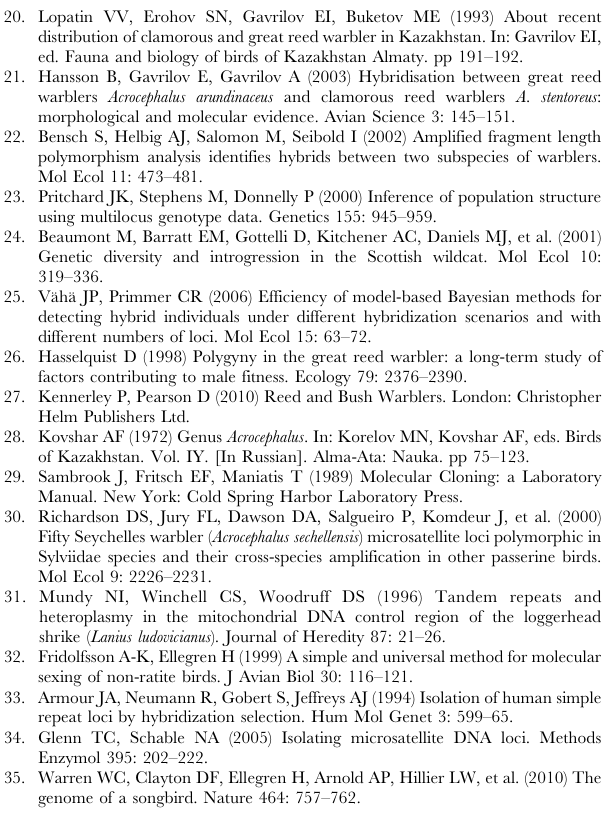
Figure S1 Chromosomal locations of great reed warbler ( Acrocephalus arundinaceus ) microsatellite loci and four other avian microsatellite loci included in the present study (Table S1) on the zebra finch ( Taeniopygia guttata )